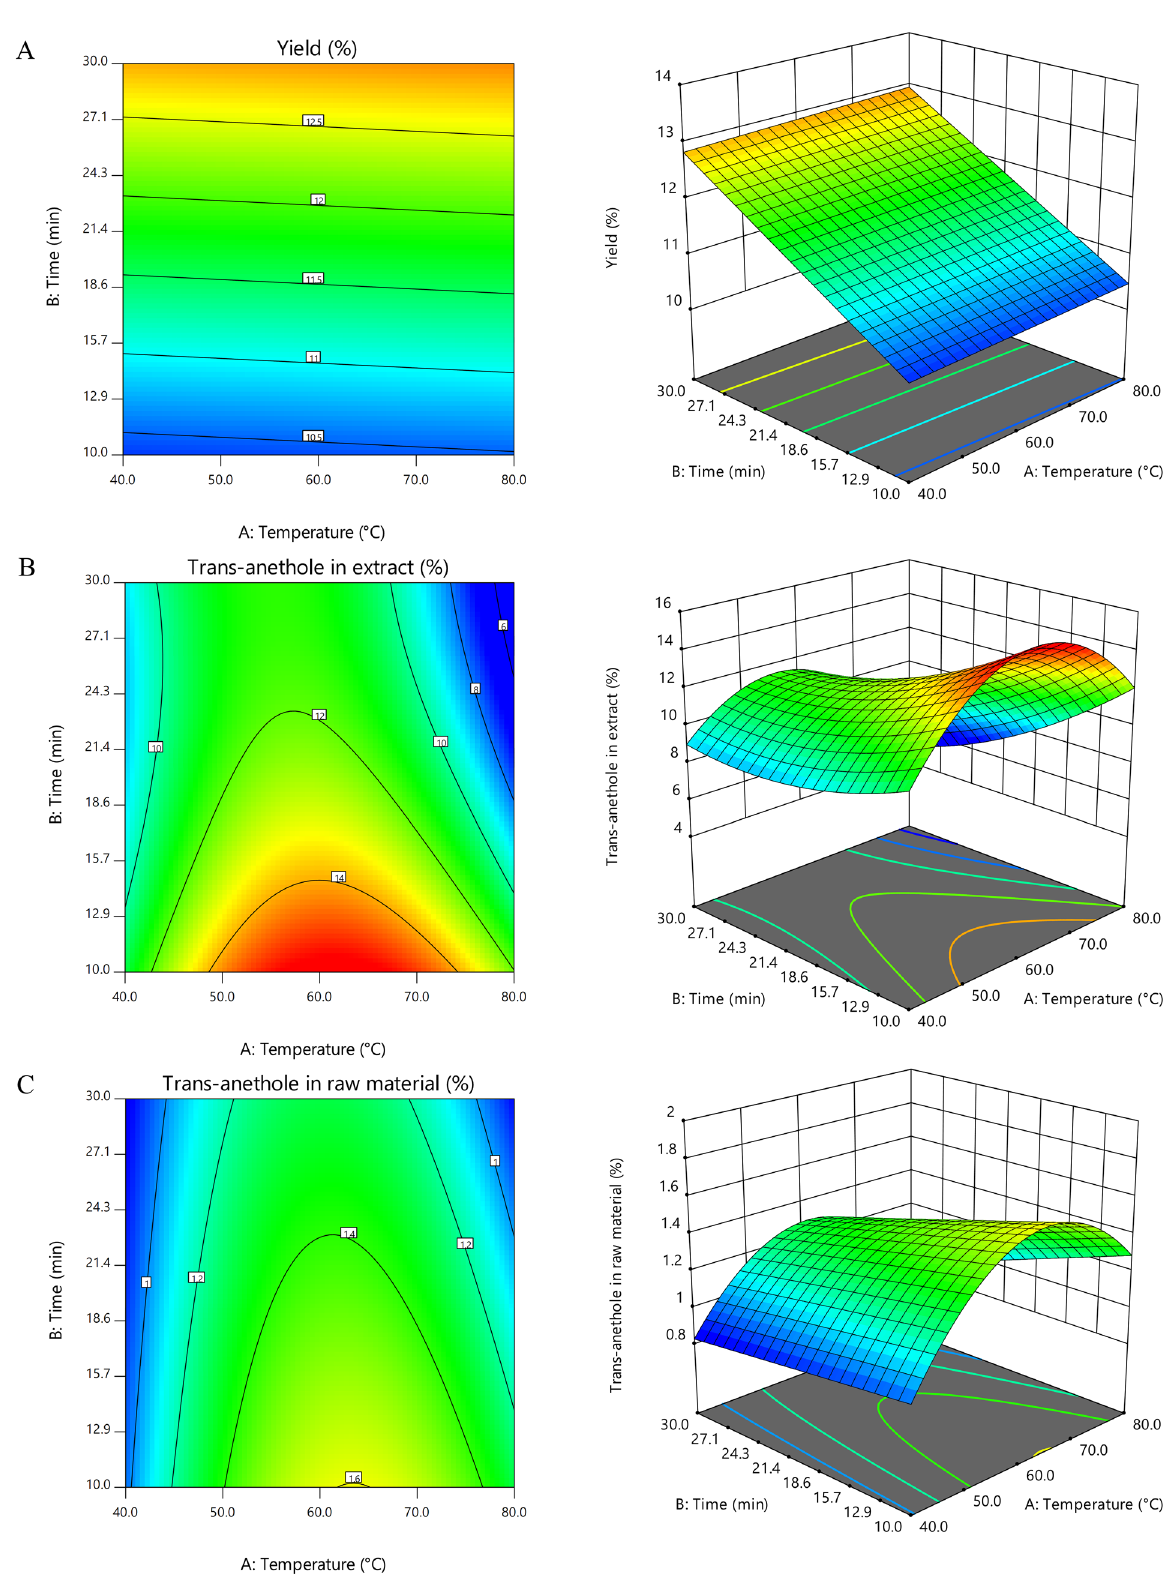
Fig. 4 Contour plots (left) and response surfaces (right) of model conditions of a extraction yield, b trans -anethole content in the extract, and c trans -anethole content in the plant raw